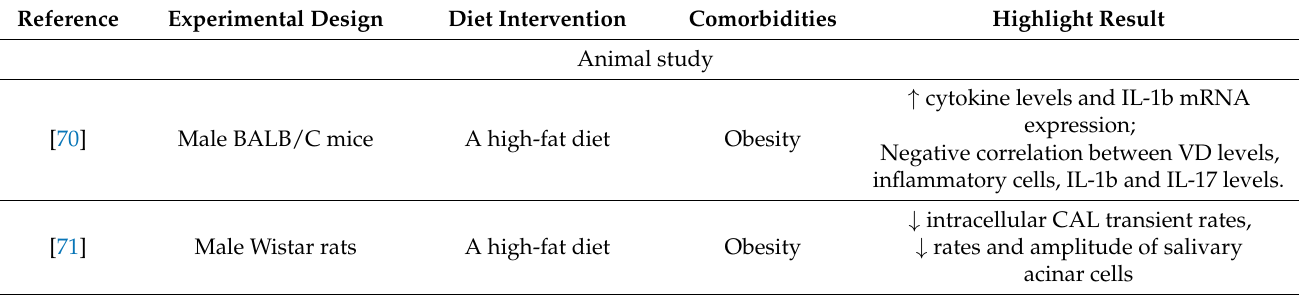
Table 5. VD–CAL in inflammatory, insulin, hormone, and cell